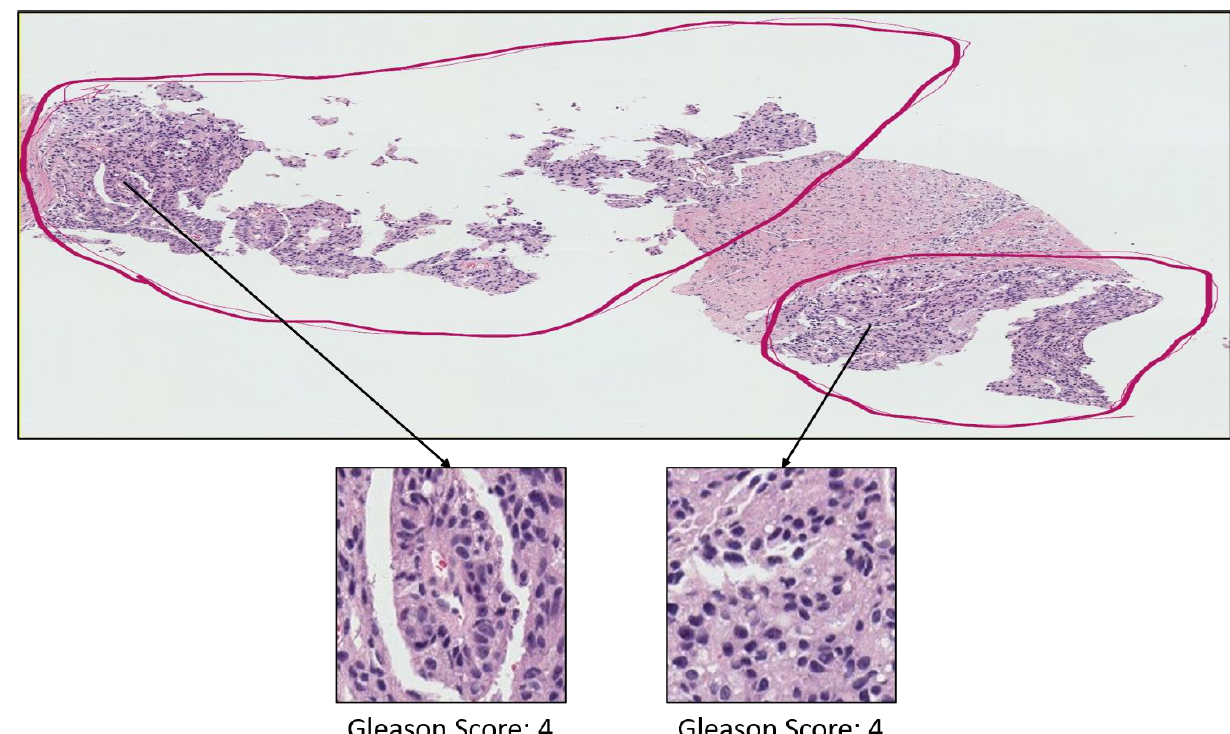
Figure A2. Prostate adenocarcinoma with Gleason scores 4 annotated with red color.